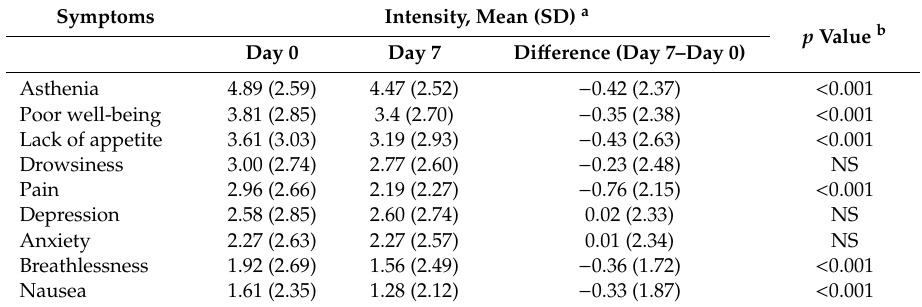
Table 4. Changes in intensity of the main symptoms from day 0 to day 7 in 508 patients.